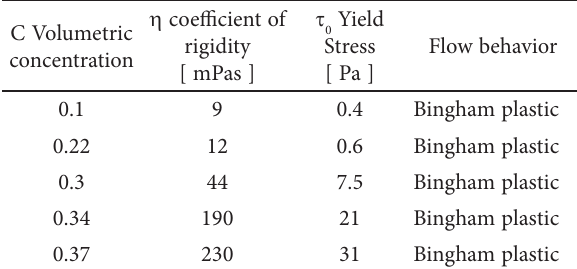
Table 7. Flow properties of Neyveli – India, Fly Ash: